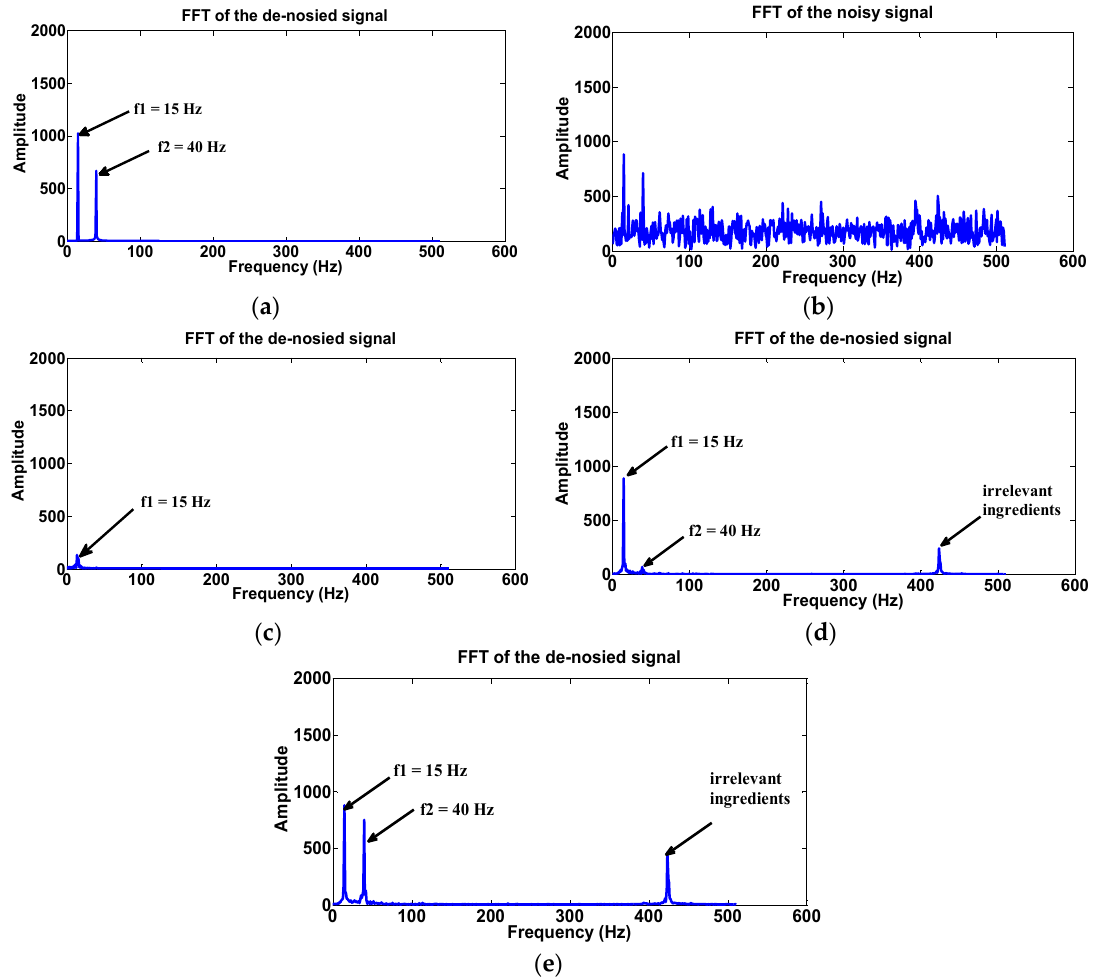
Figure 5. Frequency spectrum of original signal and de ‐ noised signal using five different methods with initial SNR of − 11.21 db. ( a ) Fast Fourier transform (FFT) of original signal; ( b ) FFT of noisy signal; ( c ) FFT of de ‐ noised signal based on MPODSOISE, MPOCSOISE; ( d ) FFT of de ‐ noised signal based on MMBDSOISE; ( e ) FFT of de ‐ noised signal based on MMBCSOISE.